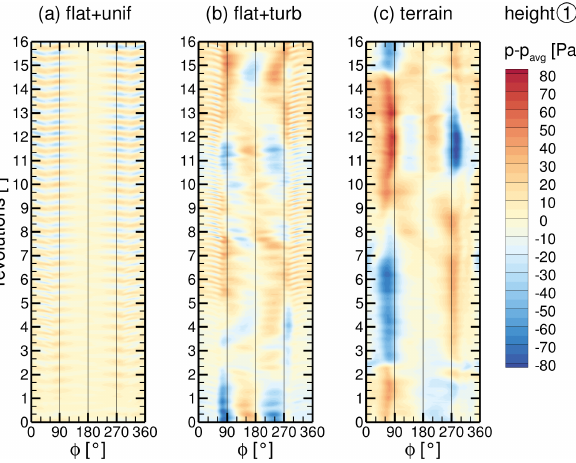
Figure 13. Time series of surface pressure fluctuations p − p avg on a line around the tower at height (1) for all cases (a) – (c)